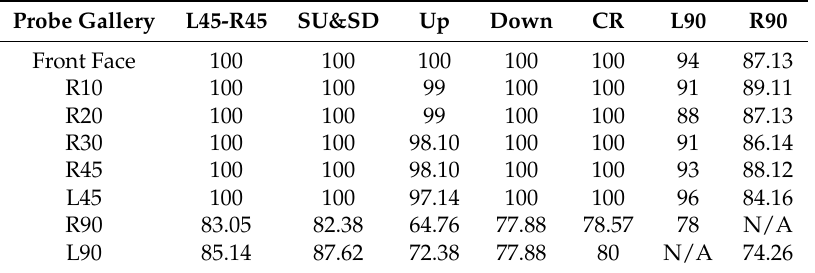
Table 3. Rank-1 identification accuracies on Bosphorus under pose rotations. R10 represents facial images under yaw rotations of 10 degrees, similar to R20, R30, R45, R90. L45 represents yaw rotations of − 45 degrees, similar to L90. CR represents yaw rotations of 45 degrees and pitch rotations of 20 degrees. SU and SD represent pitch rotations of slight upwards and slight downwards. Up and Down represent pitch rotations of upward and downward.